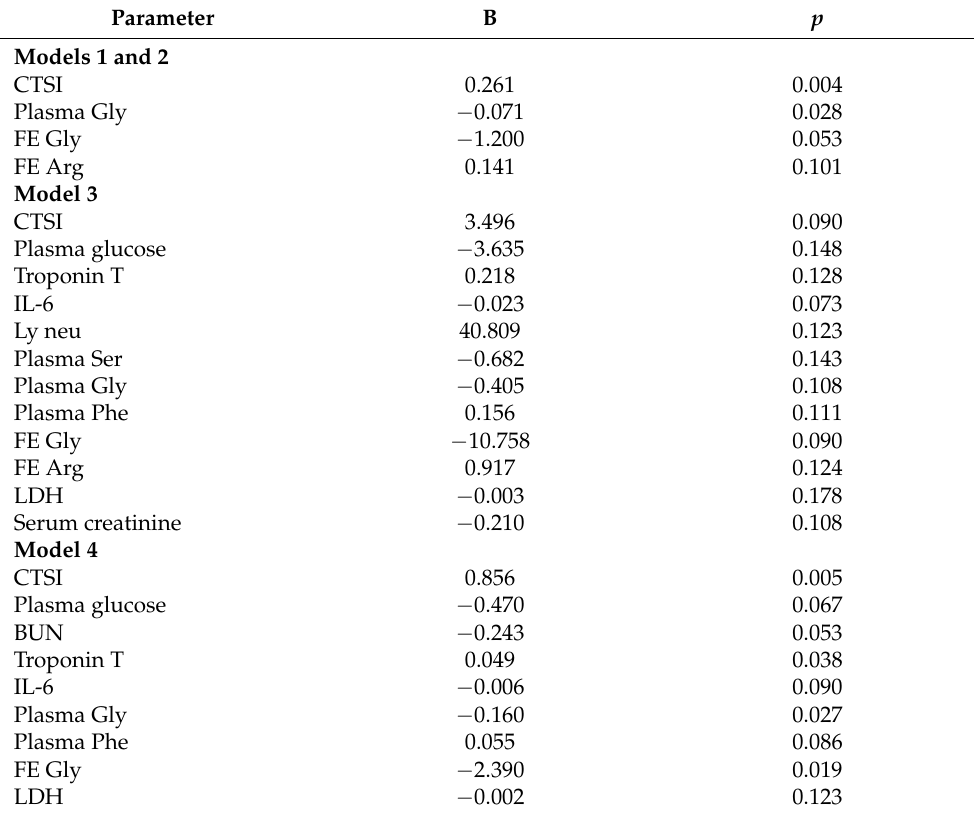
Table 4. Predictors of mechanical